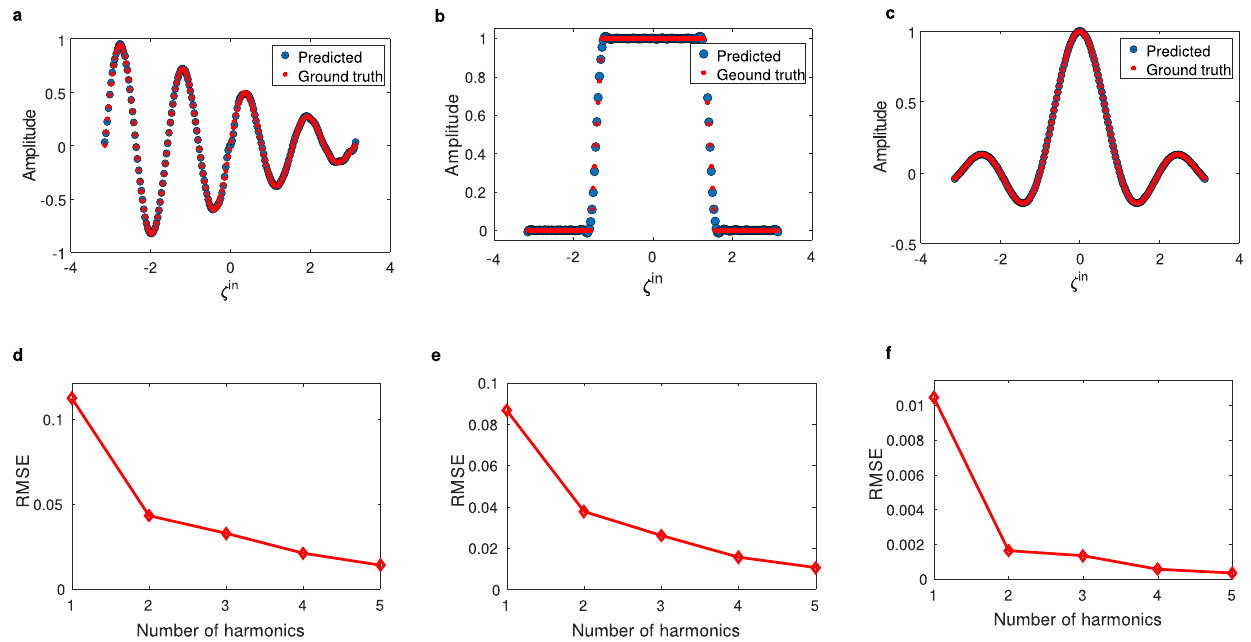
Fig. 3 Floquet extreme learning for highly nonlinear maps. a – c Comparison between ground truth and predicted values for three different nonlinear ¼ α sin ð 4 πζ in Þðj ζ in j = π Þ , and y = rect( ζ in ) and y ¼ sin ð πζ in Þ = ð πζ in Þ , respectively. d – f The corresponding values of root-mean-square error functions: y 2 1 3 (RMSE) upon increasing the numbers of involved Floquet harmonics at the readout